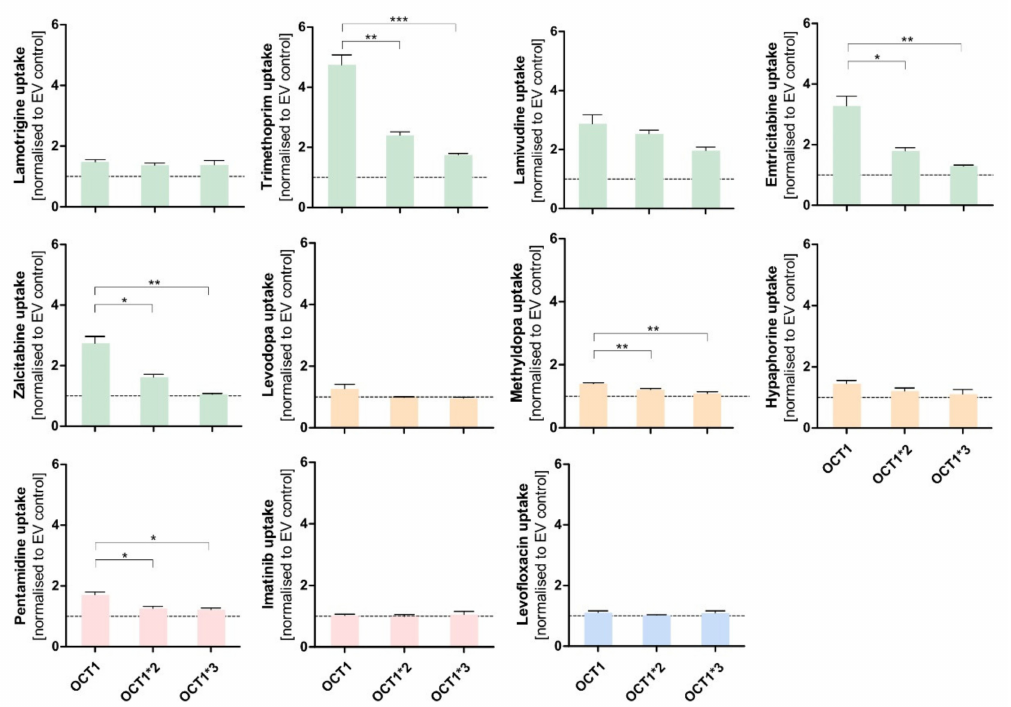
Figure 6. Effect of the naturally occurring OCT1 variants *2 and *3 on the transport of atypical substrates of OCT1. HEK293 cells that were transfected stably with OCT1*1 as well as with the variants OCT1*2 (M420del) and OCT1*3 (R61C). All these cell lines were incubated with 1 µ M of the shown substances for their substrate-specific incubation time (Table 1). The substrates are grouped based on their overall charge which is indicated by the characteristic colour. The uptake by OCT1 and its variants were normalised to the uptake by the empty vector, and a zero net-transport rate is indicated with a dotted line. The experiments were conducted at least three times (n ≥ 3) independently from each other for every substance. Statistical significance between OCT1 and its variants was determined using an unpaired students t -test with * p < 0.05, ** p < 0.01, and *** p < 0.001. No adjustment for multiple testing was performed because every comparison should be considered as a separate